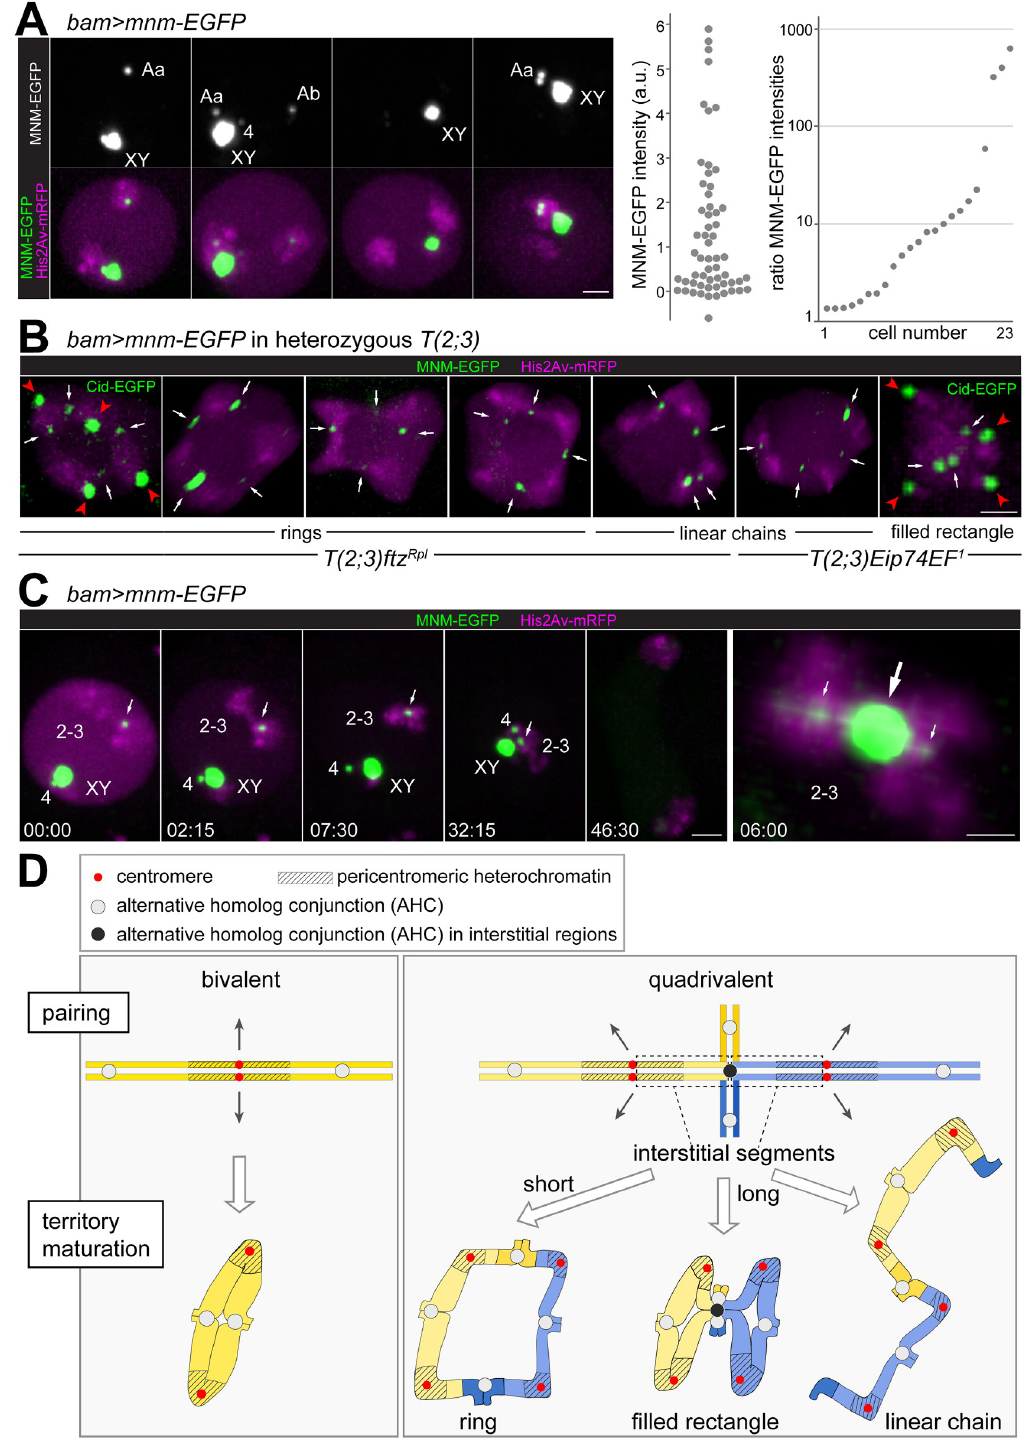
Fig 6. MNM-EGFP dots on quadrivalents. ( A-C ) AHC protein localization was analyzed by time-lapse imaging of spermatocytes with bam > mnm-EGFP and His2Av-mRFP . ( A ) Still frames from four distinct control spermatocytes at onset of NEBD I illustrate the variability in number and intensity of chromosomal MNM-EGFP dots. While the MNM-EGFP dot on the chrXY bivalent (XY) was invariably strong, autosomal dots on the bivalents of chr4 (4) and the two large autosomes (Aa and Ab) were detected as indicated. The swarm plot displays MNM-EGFP signal intensities associated with large